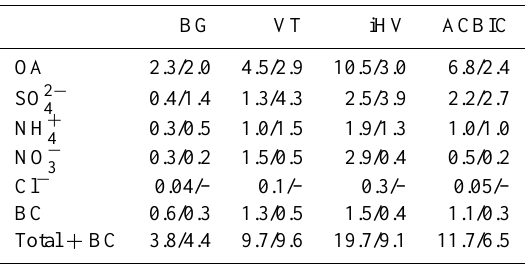
Table 2. Summary of mean mass concentrations (µgm − 3 ) of the NR-PM 1 compounds and BC for four main source regions both dry and wet seasons (dry/wet).